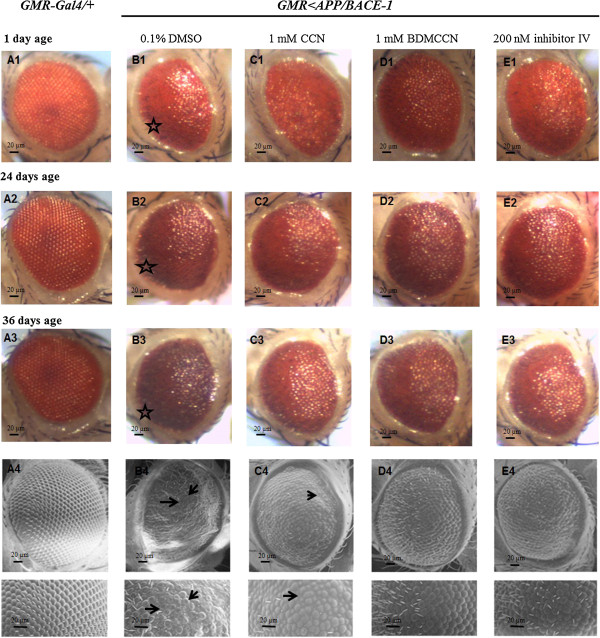
Rough eye phenotype associated with GMR < APP/BACE-1 Drosophila eye development observed by light microscope and scanning electron microscope. Light micrographs of GMR < GAL4 flies (A1-A3), GMR < APP/BACE-1 cultured on 0.1% DMSO (B1-B3), 1 mM curcumin (C1-C3), 1 mM bisdemethoxycurcumin (D1-D3), and 200 nM β-secretase Inhibitor IV (E1-E3). Scanning electron micrographs of day 36 GMR < GAL4 flies (A4) and GMR < APP/BACE-1 cultured on different media (B4-E4). Stars indicate ommatidia atrophia.